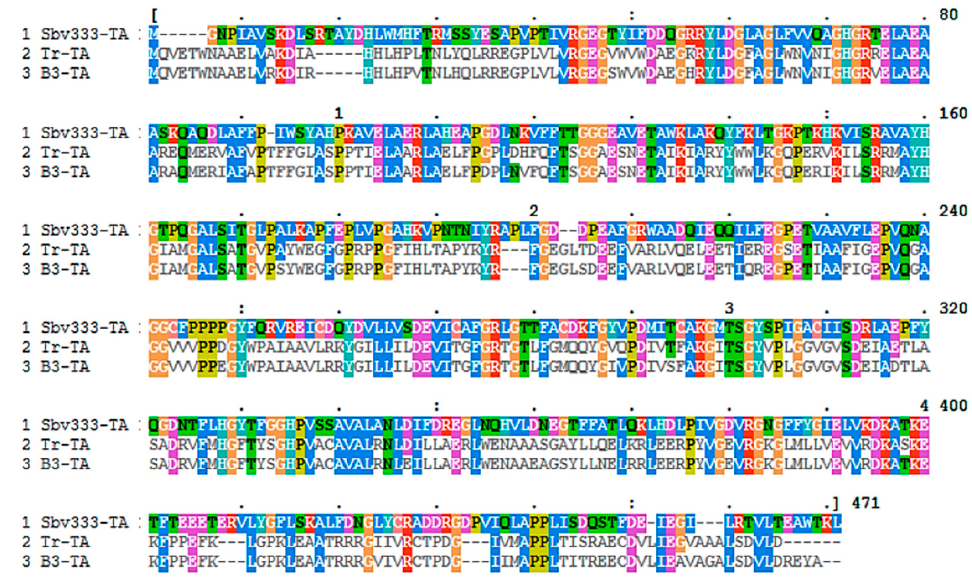
Figure 3. Multiple sequence alignment of Sbv333-TA, Tr-TA and B3-TA.